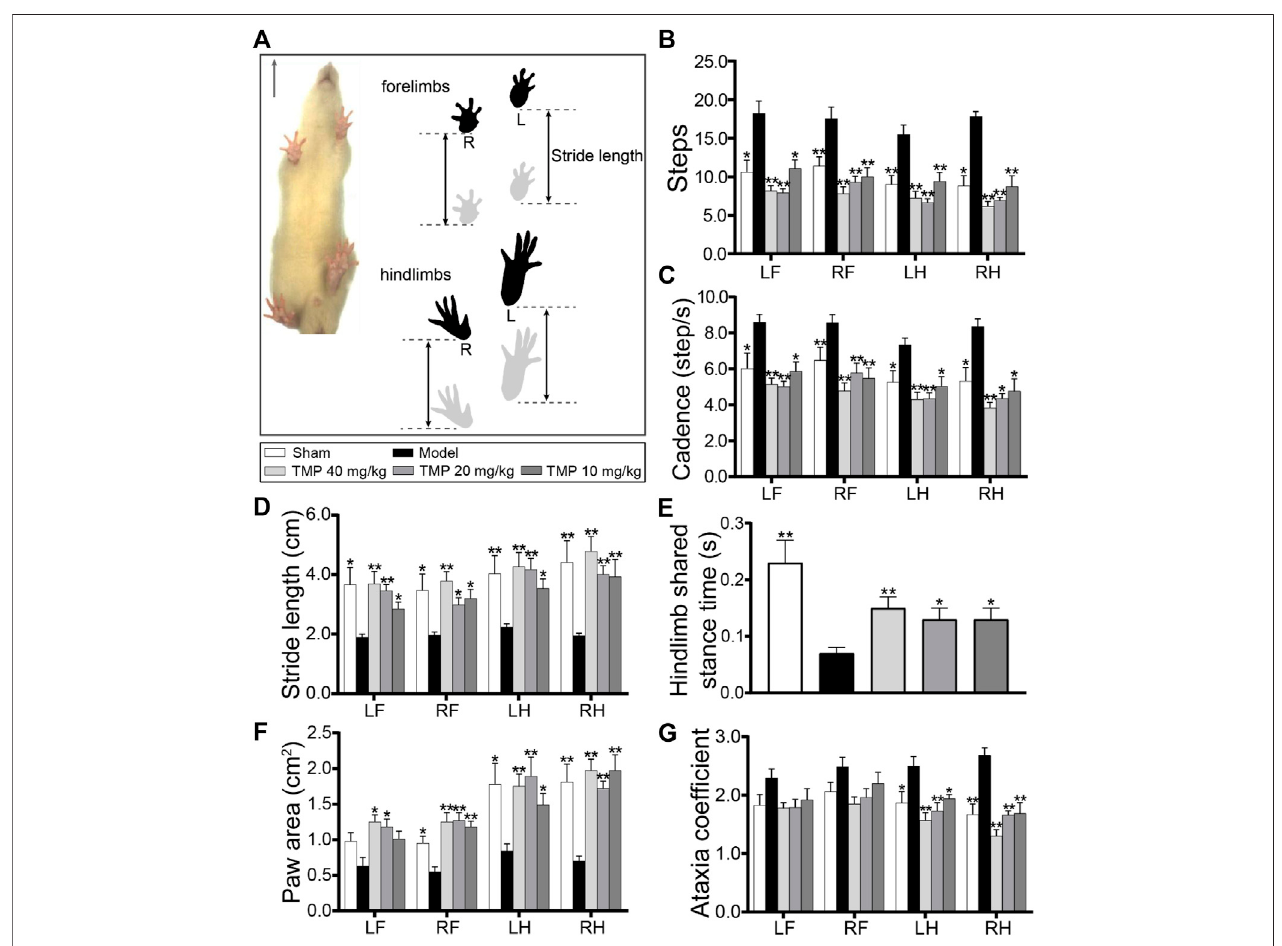
FIGURE 8 | Effects of TMP on gait functions in MCAO rats. (A) Schematic diagram exhibited a rat subjected to a gait test ( n = 10). The locations of the four paws were painted. Stride length indicated the distance between two successive initial postures during the maximal contact. Quantitative analysis of (B) steps, (C) cadence, (D) stride length, (E) hindlimb shared stance time, (F) paw area, and (G) ataxia coef fi cient in rats of each group. LF, left forelimb; RF, right forelimb; LH, left hindlimb; RH, right hindlimb. * p < 0.05 and ** p < 0.01 vs. Model group.